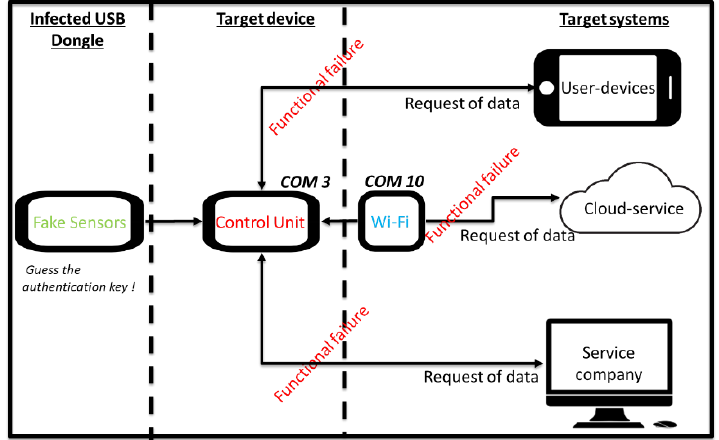
Figure 18. Authentication method vs. the distributed denial of service (DDoS) attack with infected USB dongle.